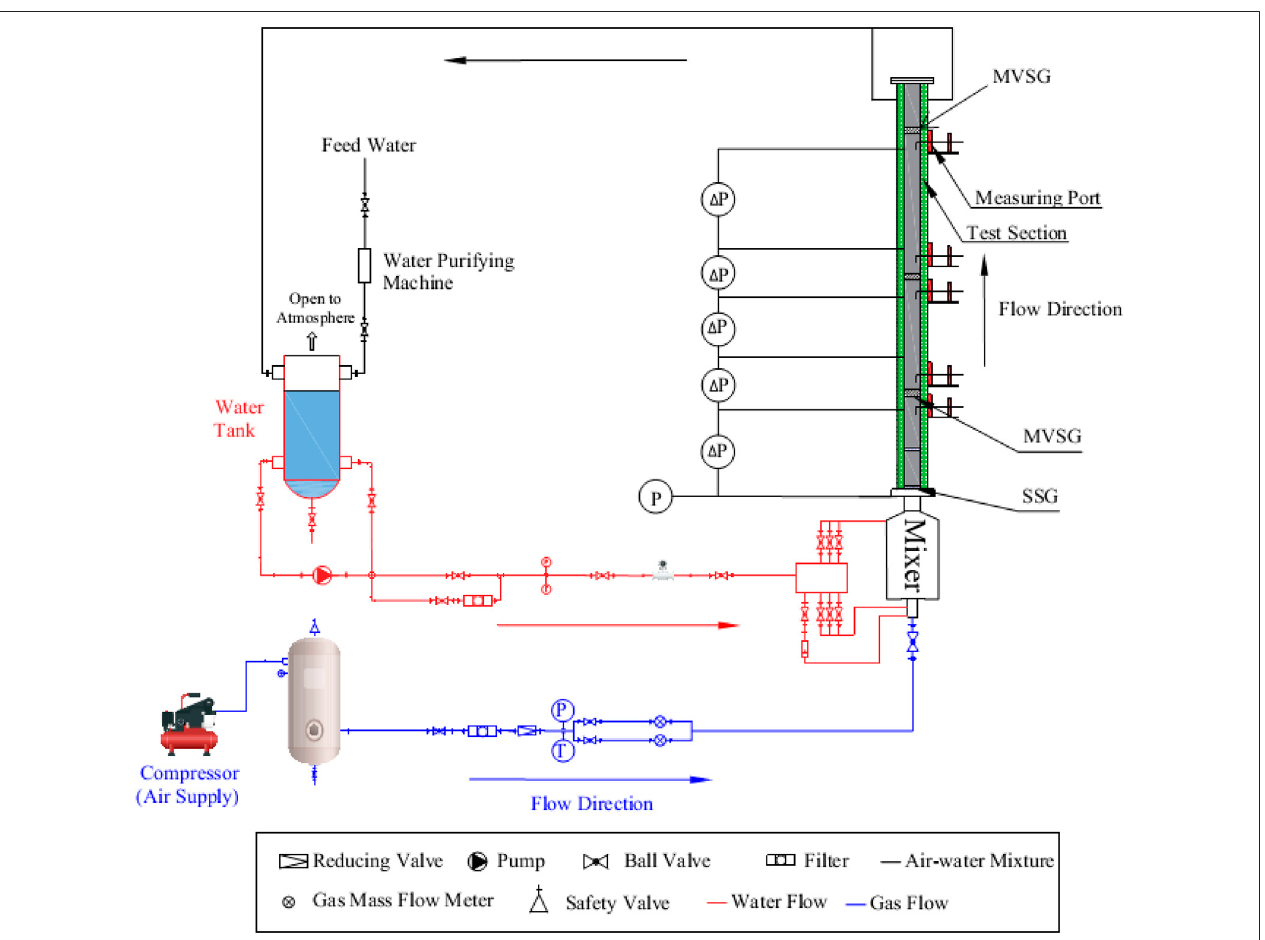
FIGURE 2 | Schematic of the experimental